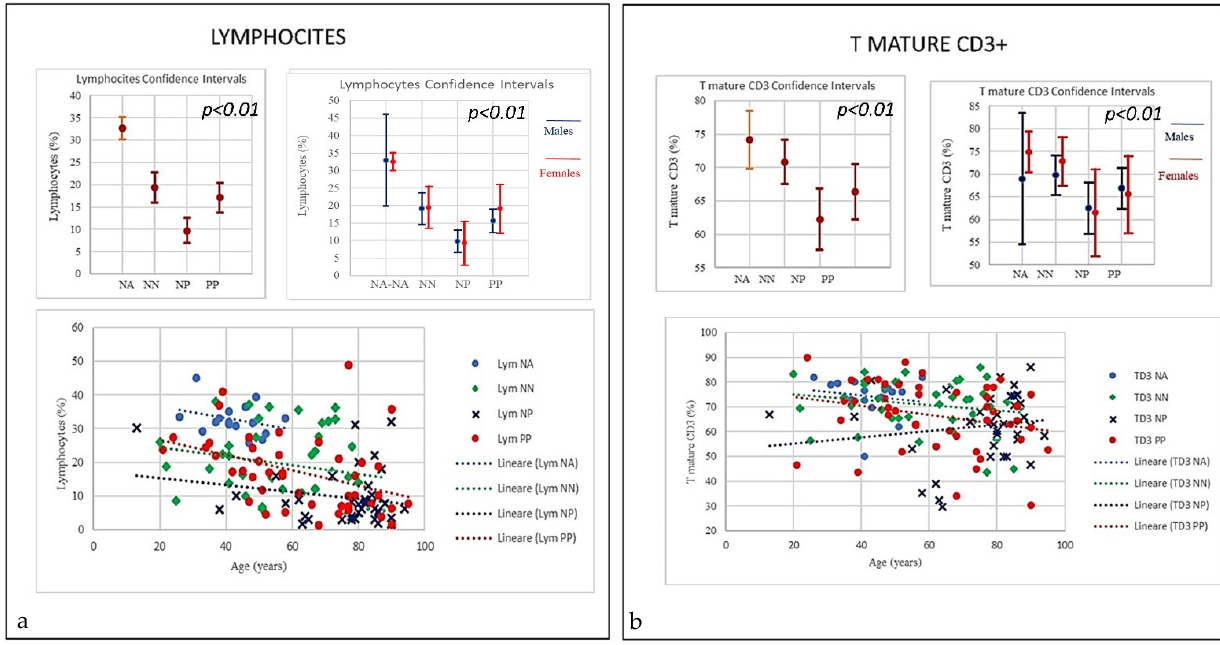
a b Figure 2. ( a ) Frequencies of Lymphocytes and T mature CD3 in COVID-19 patients and controls (NP, NN and NA). There was a decrease in lymphocytes in all PP, NP and NN, however both PP and PP the trend started from higher range whilst the NP the range started lower. Nevertheless, at certain age the, around 80, we observed the worst decay. ( b ) Frequencies of T-mature CD3 in COVID-19 patients and controls (NP, NN and NA). A negative correlation was observed between the age and the percentage of T mature CD3 between PP and NP ( p = 0.01); the PP patients T CD3 decline with age starting from higher range while in NP that line increase with age but starting from lower range ( p < 0.001).